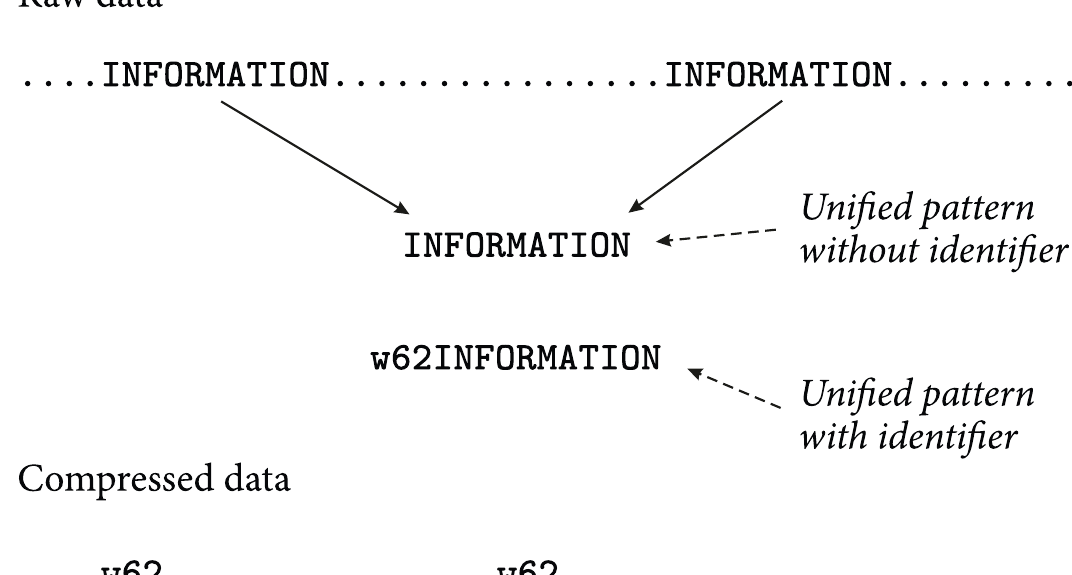
Figure 1: A schematicrepresentation of the way two instances of the pattern “INFORMATION” in a body of raw data may be unified to form a single “unified” pattern or “chunk” of information, below the “raw data”. Lower again in the figure, “w62” is added to the unified chunk as a relatively short identifier or “code”. The lowest part of the figure shows how the raw data may be compressed by replacing each instance of “INFORMATION” with a copy of the short identifer. Adapted with permission from Figure 2.3 in